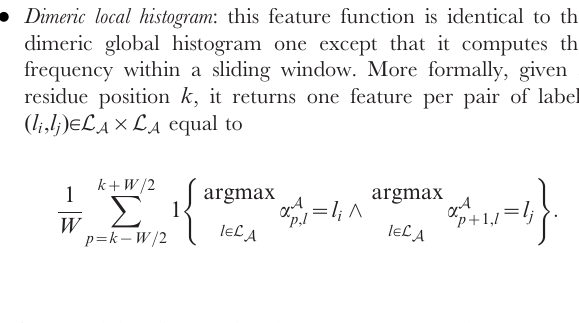
Table 2. Feature functions used in our experiments to encode residues.